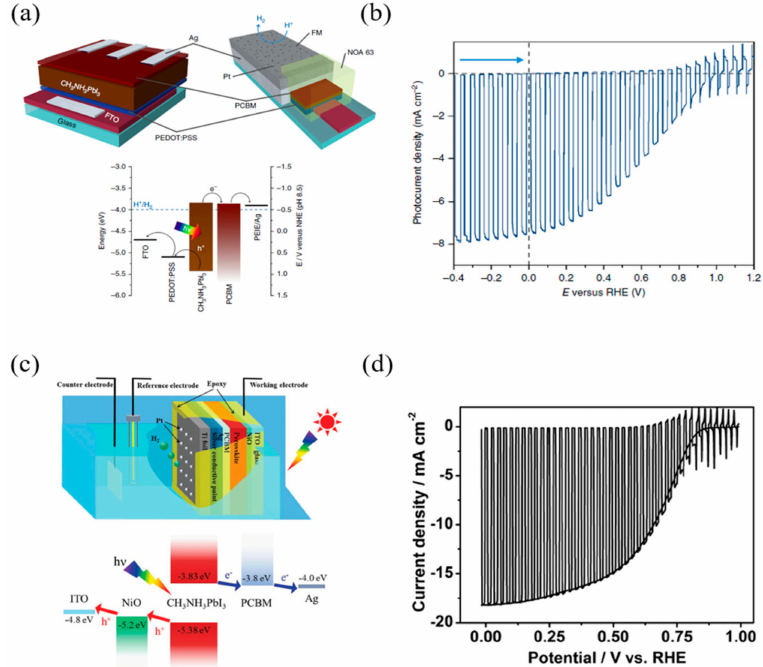
Figure 6. Examples of the p–i–n configuration of perovskite-based PEC cells. ( a ) Material and electronic configuration of the perovskite-based photocathode. ( b ) Linear sweep voltammetry of the perovskite-based photocathode at a scan rate of 5 mV s − 1 . ( c ) Schematic illustration of the sandwich-like CH 3 NH 3 PbI 3 photocathode for PEC H 2 evolution in a standard three-electrode system. ( d )